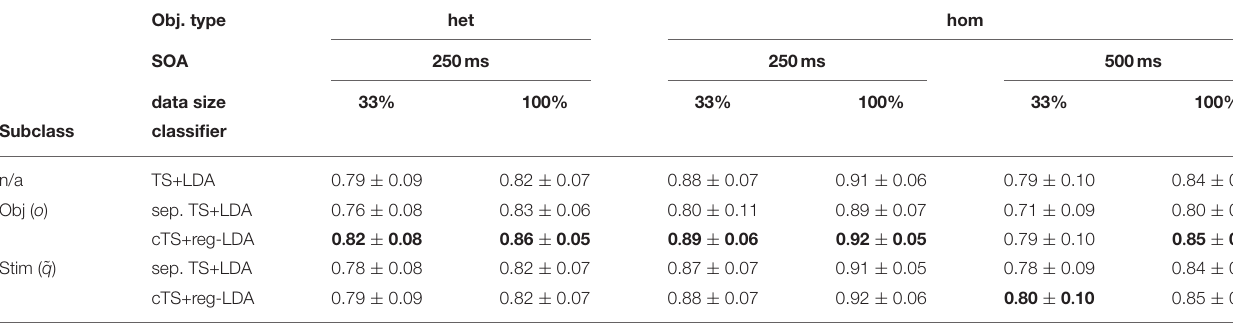
TABLE 2 | Performance of the different classification approaches on the evaluated datasets. Obj.